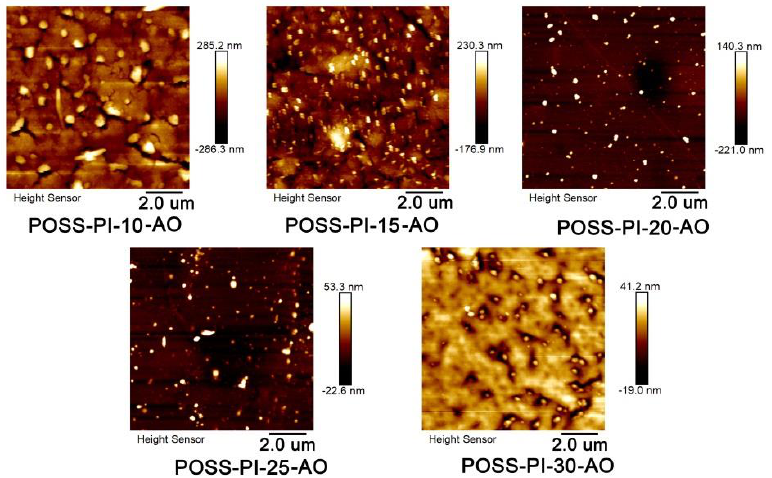
Figure 12. Atomic force microscopy (AFM) patterns of POSS-PI composite films after AO exposure (Fluence: 2.51 × 10 21 atom/cm 2 ).